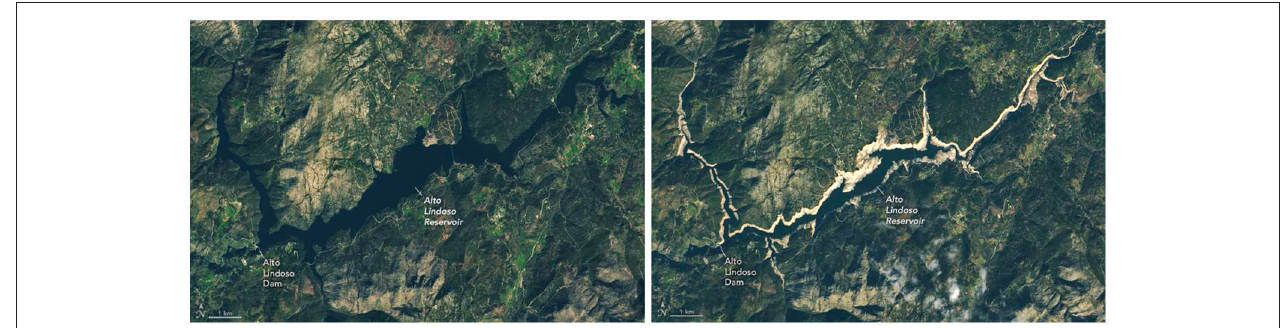
FIGURE 1 | Tracking the impact of drought on a hydropower reservoir at the Alto Lindoso Dam in Portugal from March 6, 2021 (L) to February 5, 2022 (R) , using Landsat 8 data [Credit: NASA Earth Observatory image by Lauren Dauphin, using Landsat data from the U.S. Geological Survey (NASA Earth Observatory, 2022)].